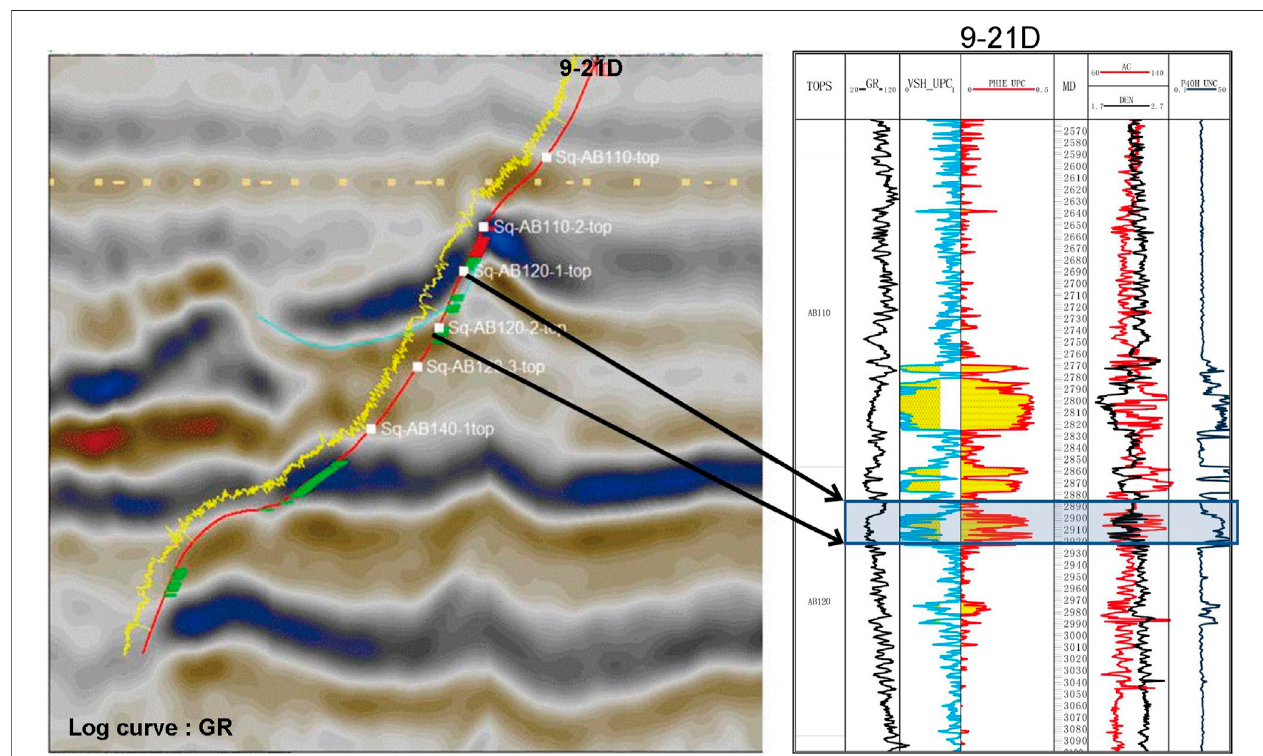
FIGURE 4 | Well-log and seismic response characteristics of the sandy channels.